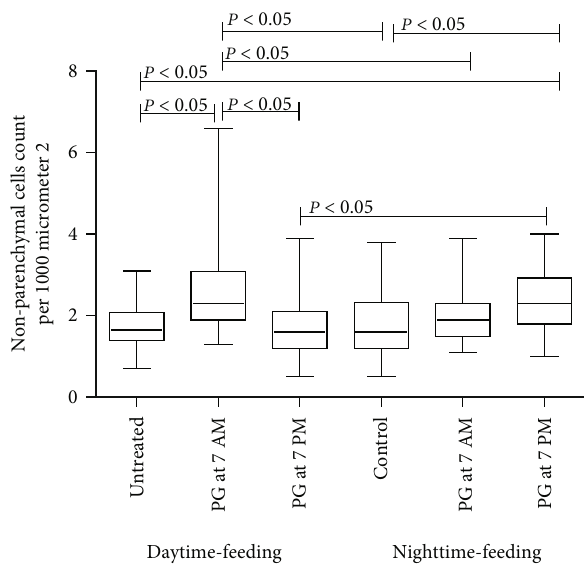
Figure 6: Comparison of nonparenchymal cell counts in the liver tissue of experimental animals.